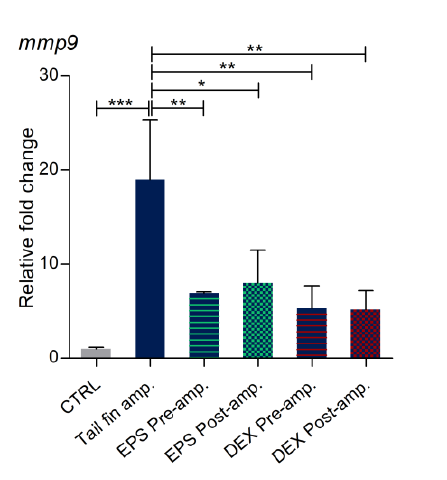
Figure 8. Expression of immune responsive genes in tail fin amputated larvae. qRT-PCR analysis of il8 , il6 , il1b , mmp9 , and mmp13 expression levels was performed with 3 dpf zebrafish larvae under basal conditions and tail cut amputation with or without dexamethasone (DEX) and EPS treatments. The data represent the mean ± SD of three independent experiments conducted with 12–15 larvae. amp. = amputation. Statistical analysis was performed using GraphPad Prism 7 (one-way ANOVA followed by Tukey’s multiple-comparison test). * p ≤ 0.05, ** p ≤ 0.01, *** p ≤ 0.001.